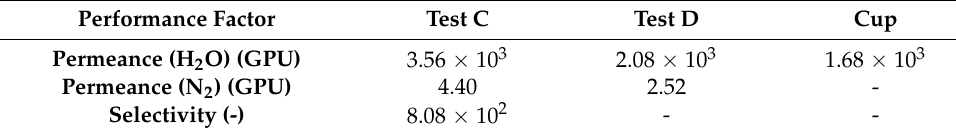
Table 5. Membrane performance factor values of Test C, Test D, and the cup method.